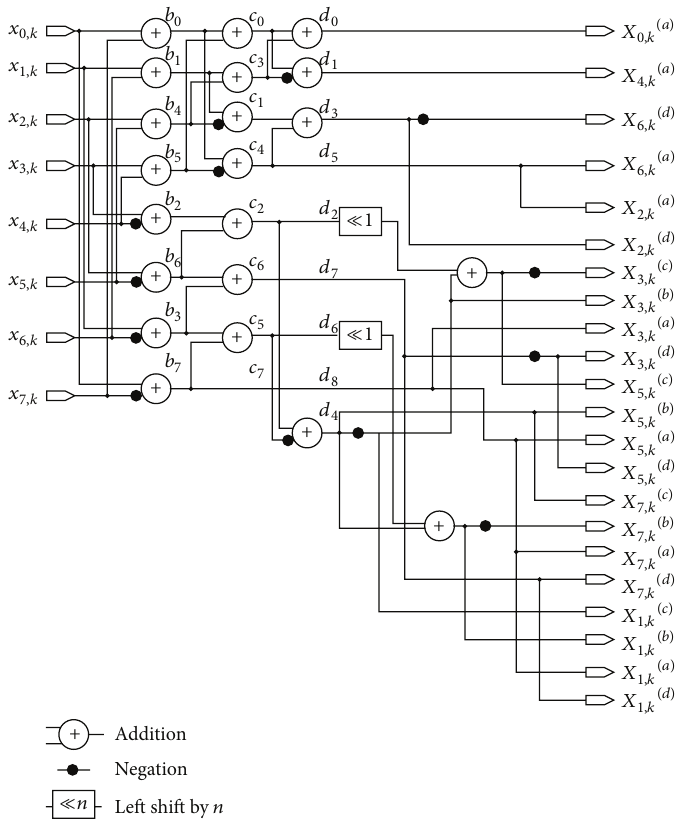
Figure 1: 1D AI Arai DCT block used in Figure 2 [16,